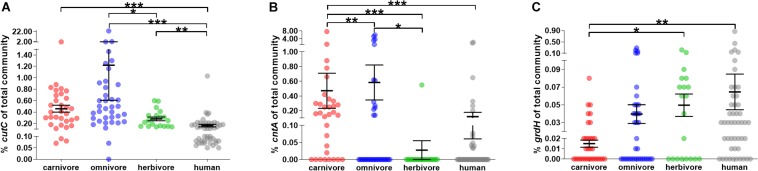
Relative abundance of genes encoding enzymes for TMA formation in mammals. (A–C) show the abundance of cutC, cntA and grdH of the total bacterial community (relative to total 16S rRNA gene abundance), respectively. In all panels, samples were grouped into herbivores (green), omnivores (blue) and carnivores (red). Human samples (gray) are shown for comparison. The black line represents the mean and its standard error. Significant differences based on FDR-corrected Kruskal–Wallis tests are symbolized as follows: ∗p ≤ 0.05; ∗∗p ≤ 0.01; ∗∗∗p ≤ 0.001. Note the y-axis breaks at 0.1 and 1.5% for cutC abundance, at 0.1 and 1% for cntA abundance and 0.02 and 0.1% for grdH abundance.